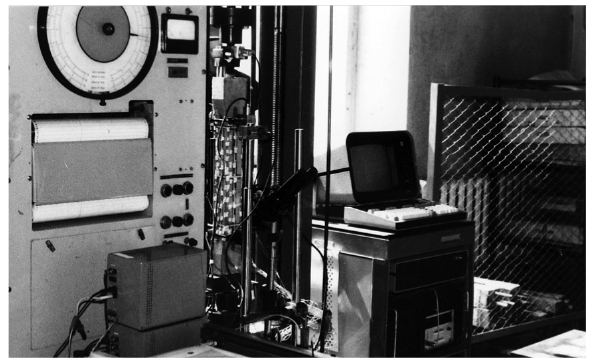
Fig. 3. Experimental set-up of a test specimen